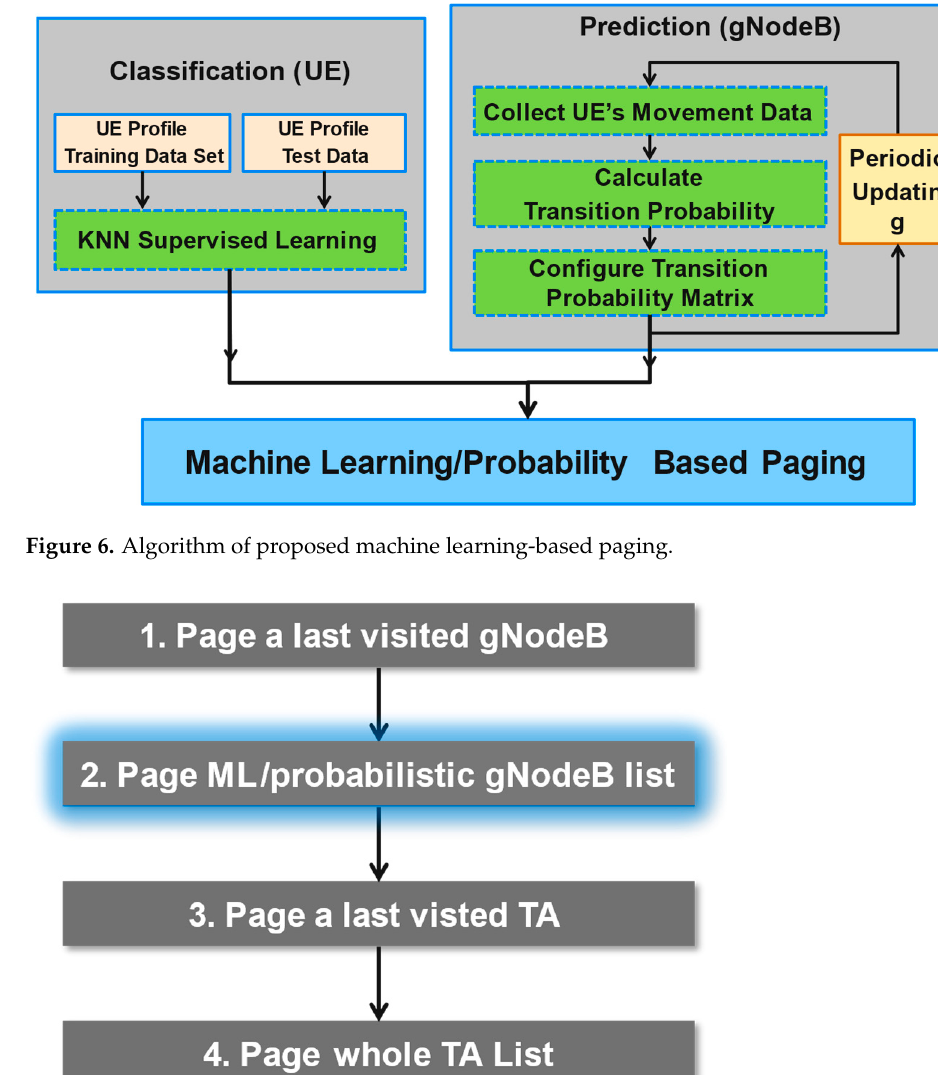
Figure 6. Algorithm of proposed machine learning-based paging.